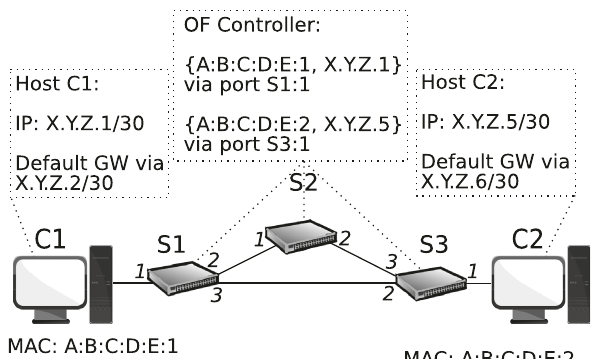
Figure 8: IP switch configuration with virtual gateway